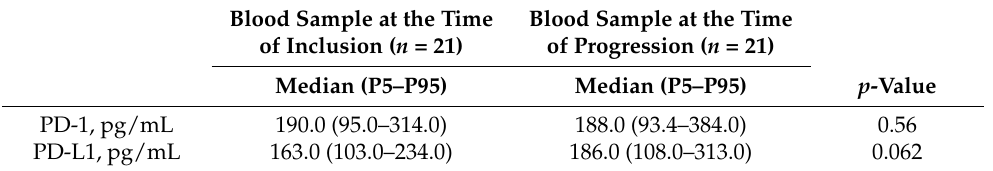
Table 4. Plasma PD-1 and PD-L1 concentrations at the time of inclusion compared to the first time of progression for patients with an available blood sample at the time of progression.